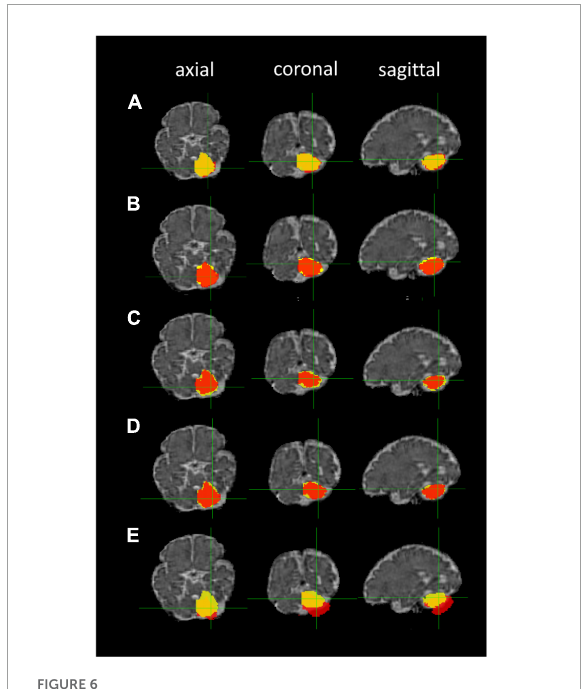
FIGURE6 Cerebellar masks: registration-based segmentation (red) versus manual segmentation (yellow). The masks are shown in axial, coronal, and sagittal planes from left to right. Row (A) ANTs linear registration (MI); (B) ANTs linear registration (CC); (C) ANTs nonlinear registration (CC); (D) ANTs nonlinear registration (MI); and (E) FLIRT linear registration.